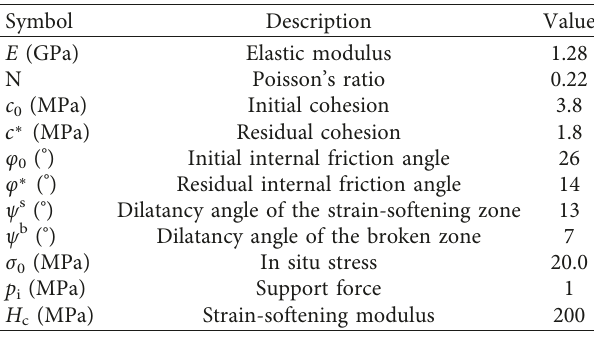
Table 1: Geometrical and mechanical parameters.